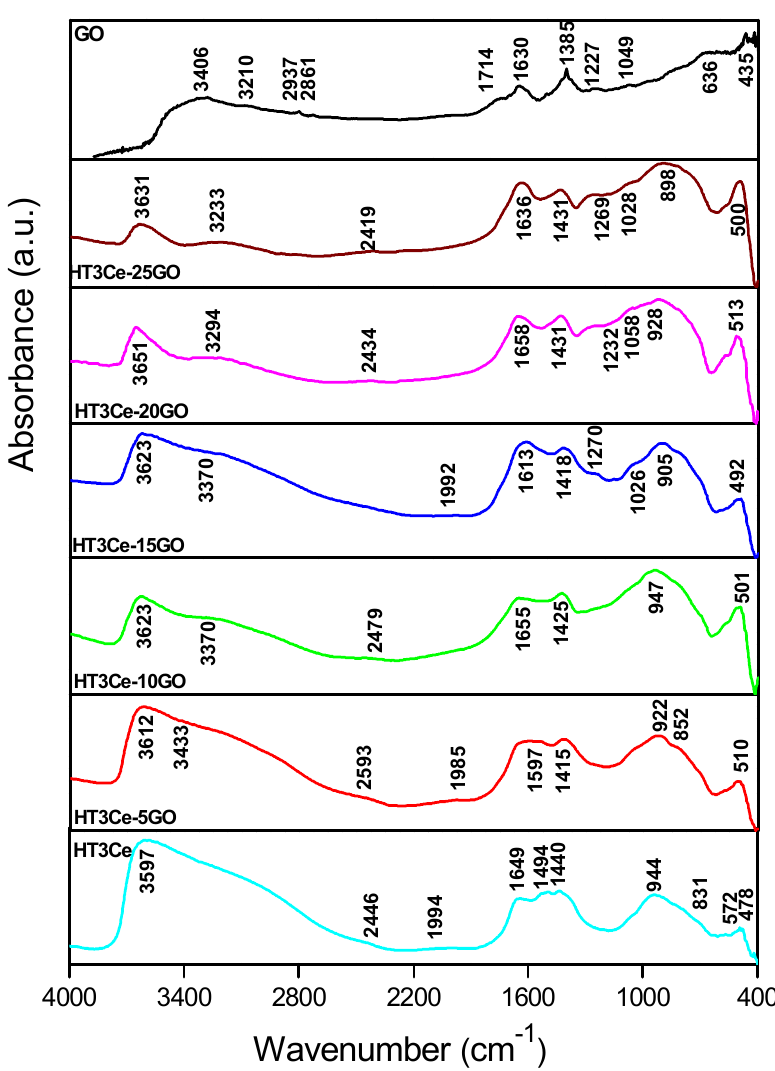
Figure 3. DRIFT spectra of the solids: HT3Ce-xGO composites, neat HT3Ce, and GO. The same proportionality related to the GO concentration was observed influencing the shoulder displayed in the region at 3000–3200 cm − 1 (probably due to the formation of hydrogen bonds between the water molecules). Furthermore, at 1645 cm − 1 , the absorption of the hydroxyl groups of the water molecules in the HT3Ce interlayer space was perturbed in the GO-containing composites and shifted towards 1597 (for HT3Ce-5GO), 1655 (for HT3Ce-10GO), 1613 (also wider, for HT3Ce-15GO), 1658 (for HT3Ce-20GO), and 1636 cm − 1 (for HT3Ce-25GO). This aspect can be explained by the different confinement of the LDH particles on the larger GO layers, in good correlation with the already observed perturbation by the “turbostratic” effect [51]. The perturbation of the interlayer region appeared due to the favorable interactions between LDH and GO, mediated by ceria ions, which could be observed further. The asymmetric stretching vibrations of CO 32 − from HT3Ce were found at 1430 cm − 1 . The same peak (in the composites containing 5, 10, 15 wt.% GO) was shifted towards a lower absolute value (1415, 1425, 1418 cm − 1 ), indicating a weaker interaction when GO was used. Moreover, the other CO 32 − vibration modes were affected in the same manner (in the 1495–1528 cm − 1